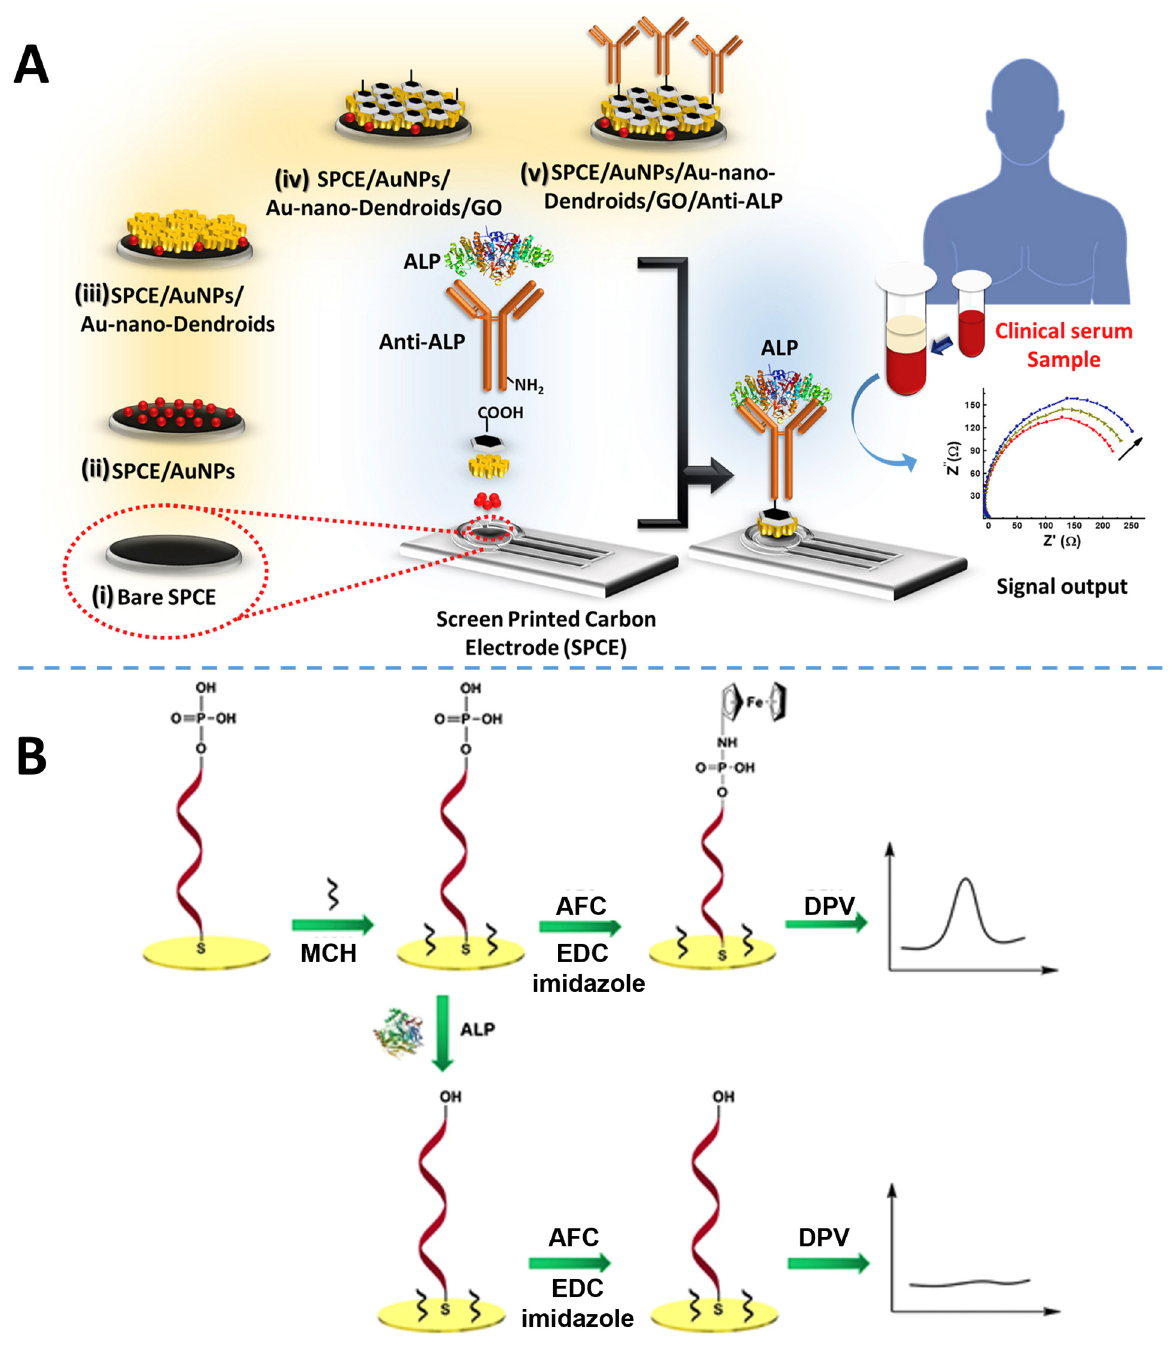
Figure 5. Schematic illustrations of: ( A ) the SPCE/AuNPs/Au-nano-dendroids/GO/anti-ALP probe for the determination of ALP in serum, and ( B ) the electrochemical assay of ALP activity based on the enzyme-catalyzed reaction. Adapted from [66,67], respectively, with permission.